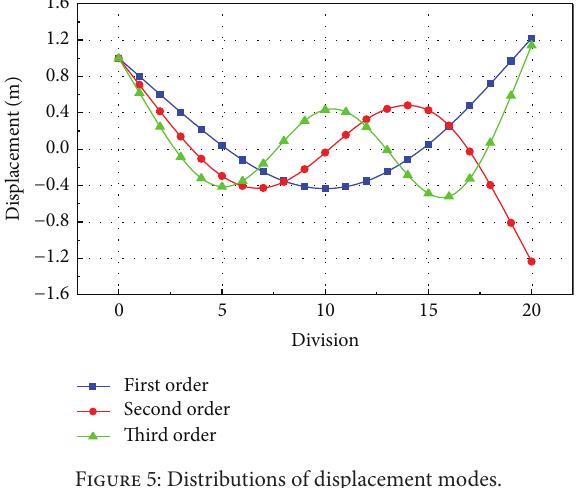
Figure 5: Distributions of displacement modes. Table 2: Wet natural frequencies of model ship.